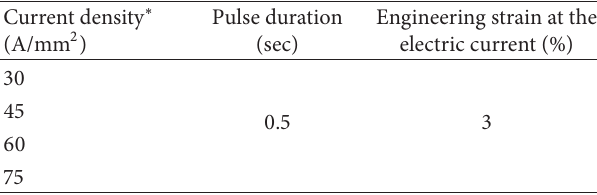
Table 1: Electric pulse parameters.